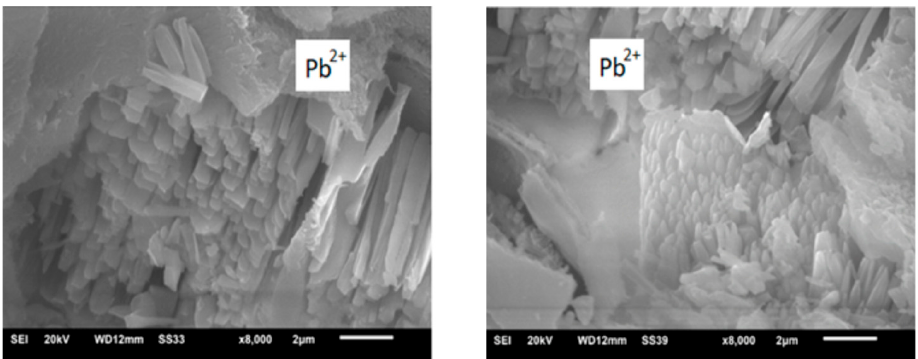
Figure 8. SEM image of PBc—Pb 2+ loaded (cluster particles).